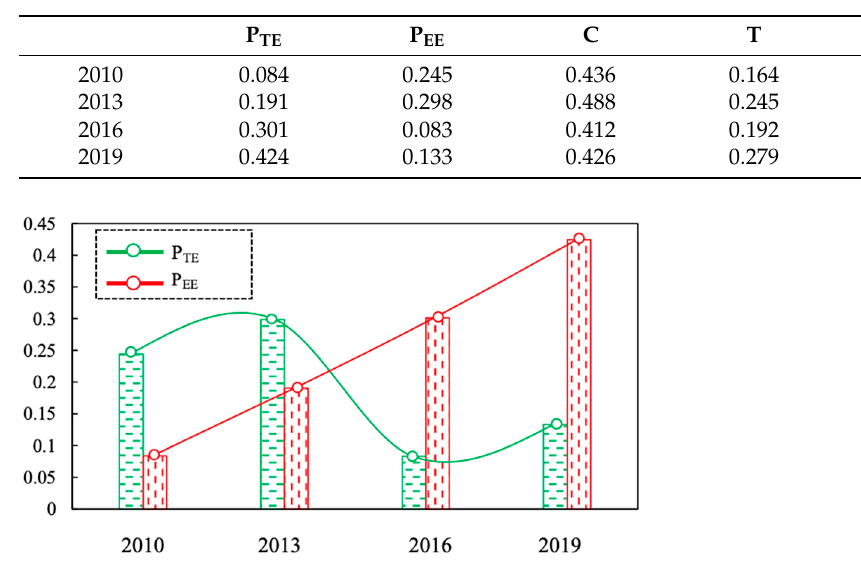
Table 3. Coupling degree and coordination degree between tourism economy and ecological envi- ronment in Nagasaki Prefecture.